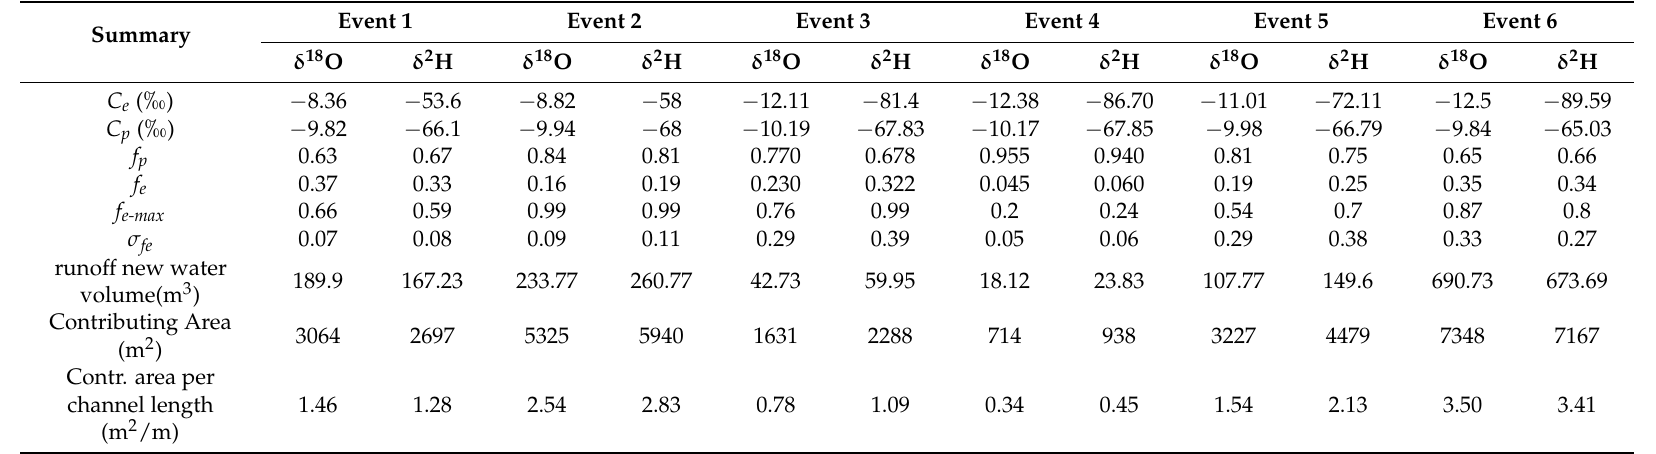
Table 3. Pre-event water contributions to storm runoff using one-tracer, two end-member hydrograph separation ( δ 18 O and δ 2 H, analysis. σ is the uncertainty, f e / f p is the total event/pre-event water volume over total storm runoff volume, f e-max is the maximum event water fraction, C refers to the isotopic signature and subscripts e, p, and t refer to event water, pre-event water and stream water,